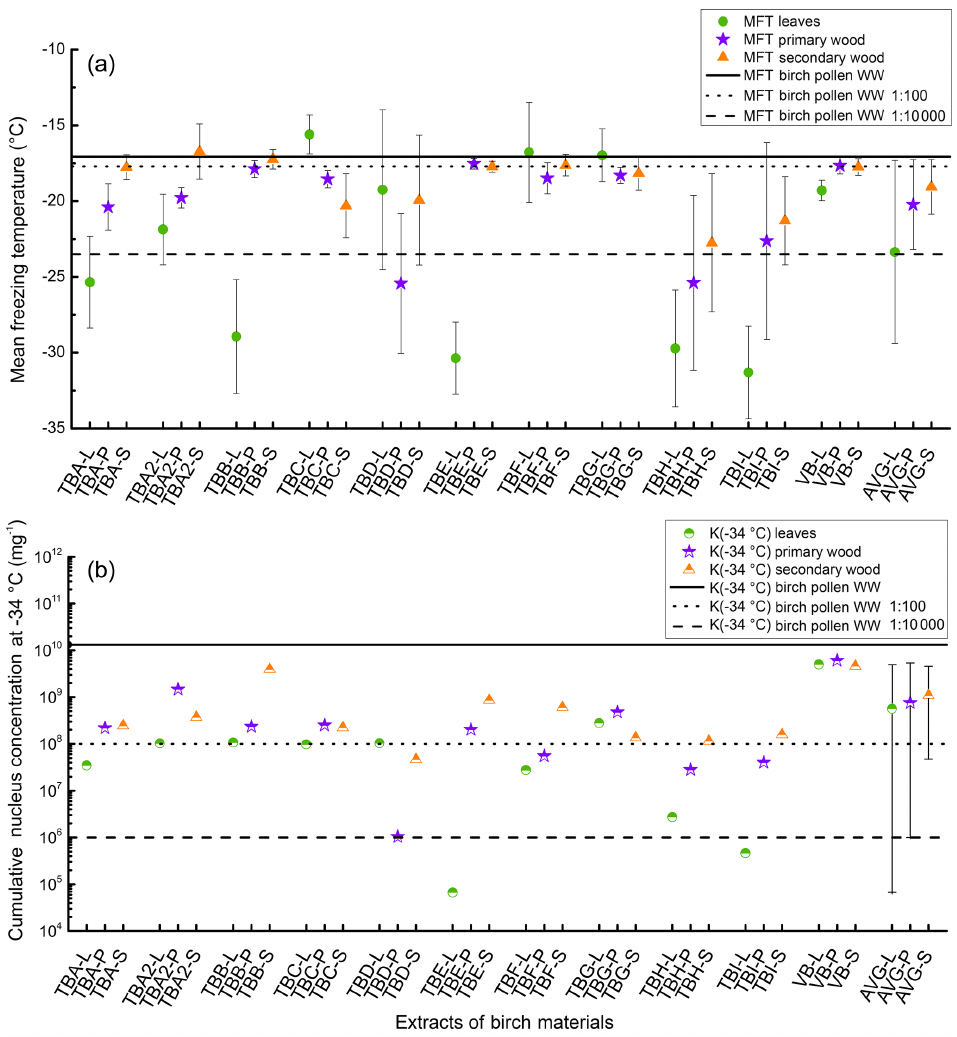
Figure 2. (a) Mean freezing temperature (MFT) of the different birch samples. Leaf extracts (L) are marked with green circles, primary wood extracts (P) with violet stars, and secondary wood extracts (S) with orange triangles. The solid line is the MFT of birch pollen washing water ( − 17 . 1 ◦ C with a standard deviation of ± 0 . 5 ◦ C (not plotted)). The dotted line represents the MFT of a dilution equivalent to 10 8 INPmg − 1 ( − 17 . 7 ◦ C with a standard deviation of ± 1 . 1 ◦ C (not plotted)) and the dashed line refers to the MFT of a dilution equivalent to 10 6 INPmg − 1 ( − 23 . 5 ◦ C with a standard deviation of ± 3 . 6 ◦ C (not plotted)). The three values on the far right side of (a) represent the average of all mean freezing temperatures for leaves (AVG-L), primary wood (AVG-P), and secondary wood (AVG-S) with the corresponding standard deviation. (b) Cumulative nucleus concentration at − 34 ◦ C ( K( − 34 ◦ C)) of the different birch samplesmg − 1 extracted sample. Assignment of the symbols is similar to the top plot. The solid line refers to the K( − 34 ◦ C) of birch pollen washing watermg − 1 extracted pollen (1 . 3 × 10 10 mg − 1 ); the dotted and dashed line refer to the dilutions from birch pollen washing water introduced in (a) . The three values on the far right side represent the average of all K( − 34 ◦ C) values. Error bars point to the area of trust, ranging from the highest to the lowest measured